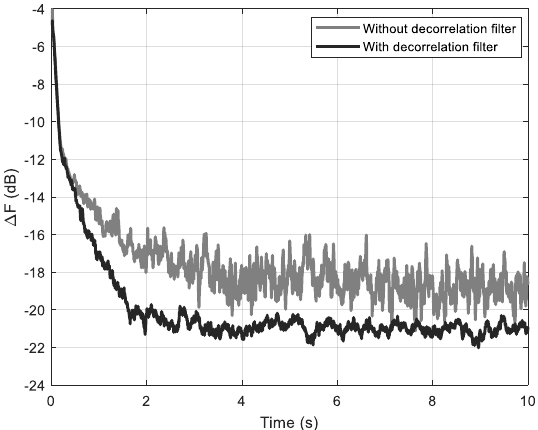
Figure 5. Feedback path modelling error in the second stage.